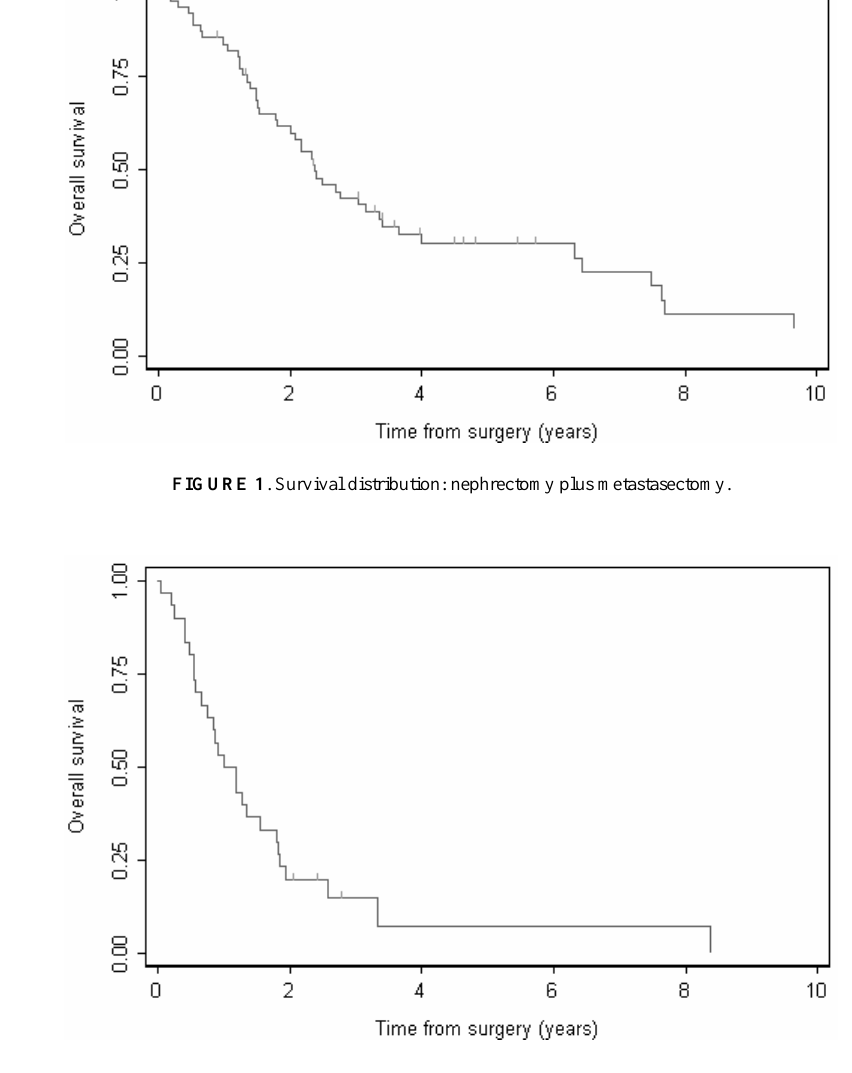
FIGURE 2. Survival distribution: cytoreductive nephrectomy